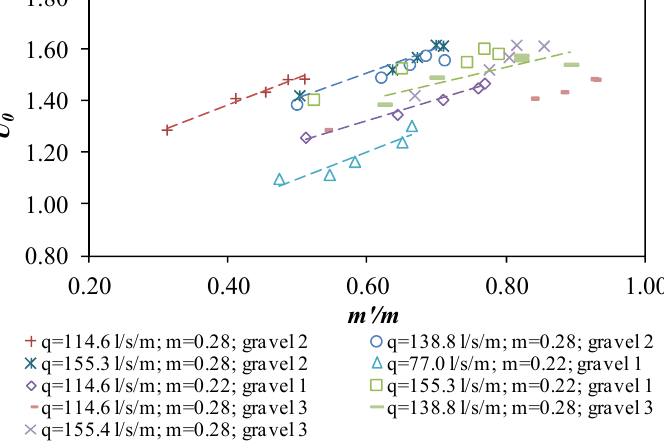
Figure 14. Velocity at the beginning of the rack U 0 as a function of the ratio between the effective and the initial void ratio, m'/m .